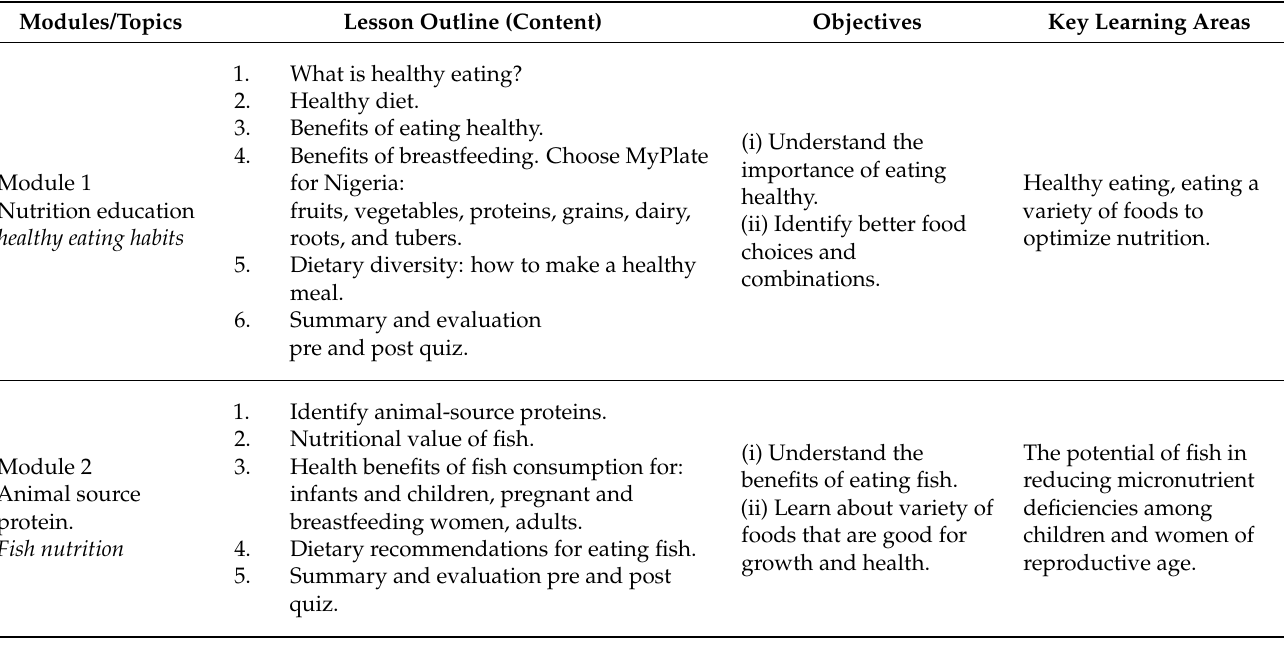
Figure 1. Flowchart for the content validation process. (This illustration is the detailed process involved in the development of the nutrition education, food safety, and safe fish-handling practice guide for fish processors. The process design was the authors’ perception based on a review of the existing literature on content validity and development commonly used in the nursing and health field).